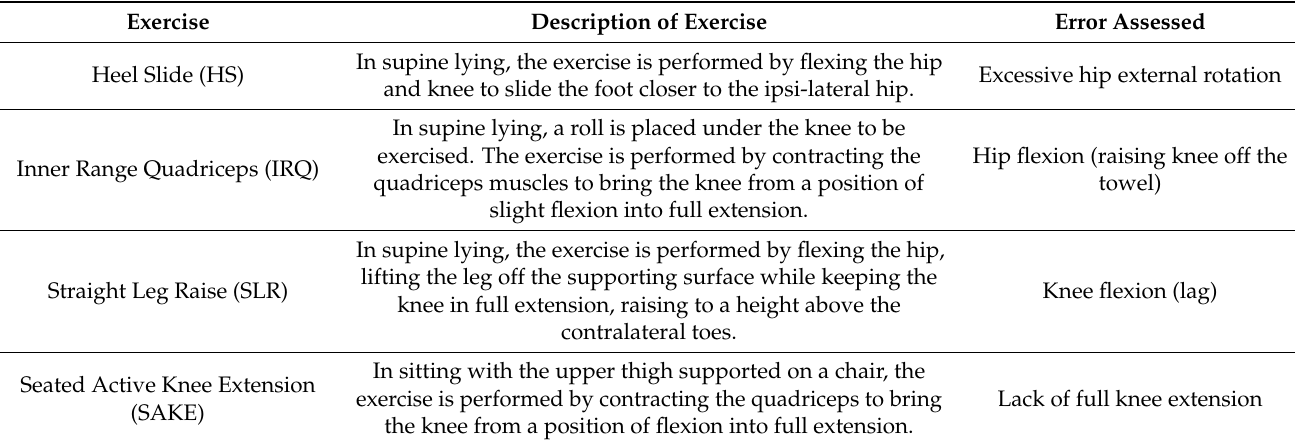
Table 1. Description of exercises and the errors assessed within the machine learning models. Exercise Description of Exercise Error Assessed